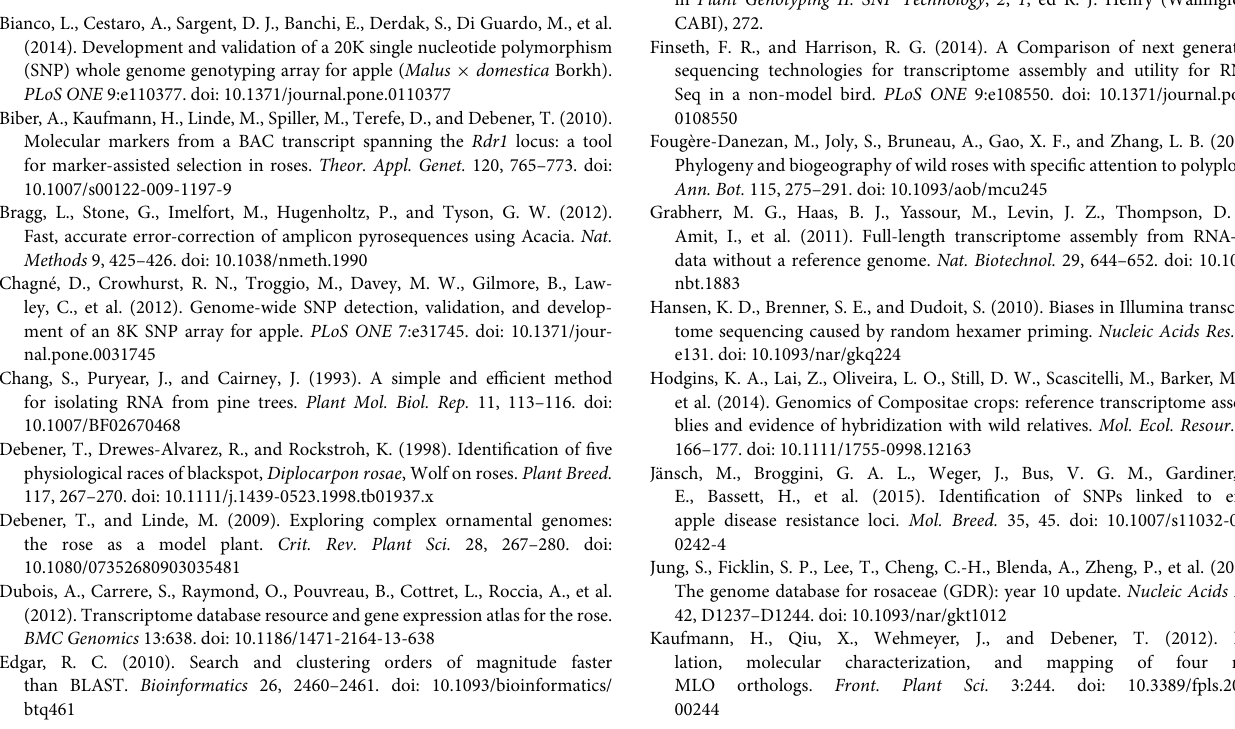
Supplementary Table ESM 2 | The complete description of all SNPs on the WagRhSNP array. For each SNP the following is listed: SNP_ID, flanking sequences, and alleles of the SNP (A/B). In addition, the Rh-Fv ortholog transcript code, the Fragaria vesca protein code, and the annotation in Fragaria are given whenever available. This file provides all sequence information about the SNPs on the array and their flanking regions, but it can also be used as a key to the most similar sequence in the Fragaria vesca (Fv) genome, if available, and vice versa. (csv) Supplementary Table ESM 3 | Orthologous ORF sequences of roses, constructed using the orthology-guided assembly procedure. The sequence header contains the Rh_Fv ortholog name and the related Fragaria (Fv) transcript annotation. (csv) Supplementary Table 3 will be uploaded to GDR and ROSAseq. Supplementary Table ESM 4 | InterPro predictions for the orthologous transcripts of cut and garden roses. The predictions originate from the related Fragaria (Fv) transcript. (csv)